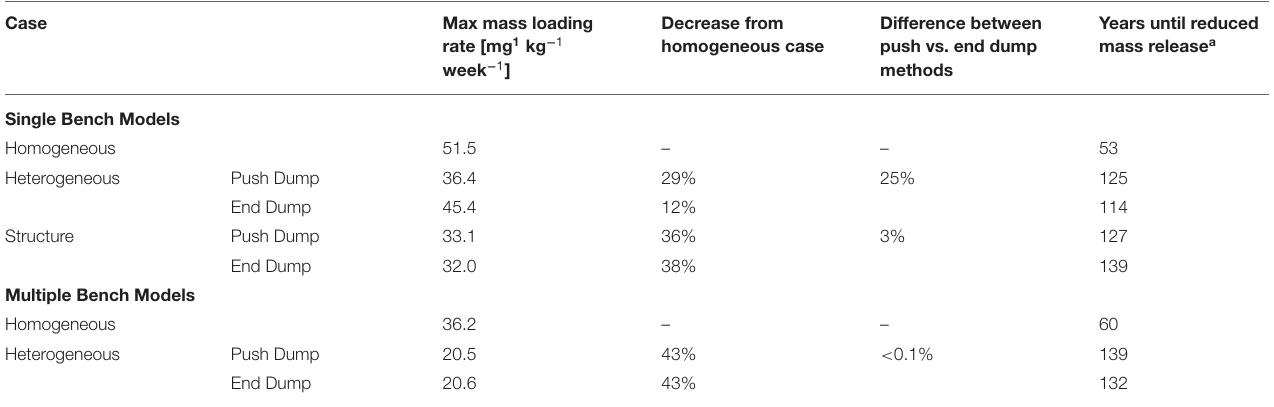
TABLE 4 | Variation in mass loading rates and duration of release with traffic surfaces and